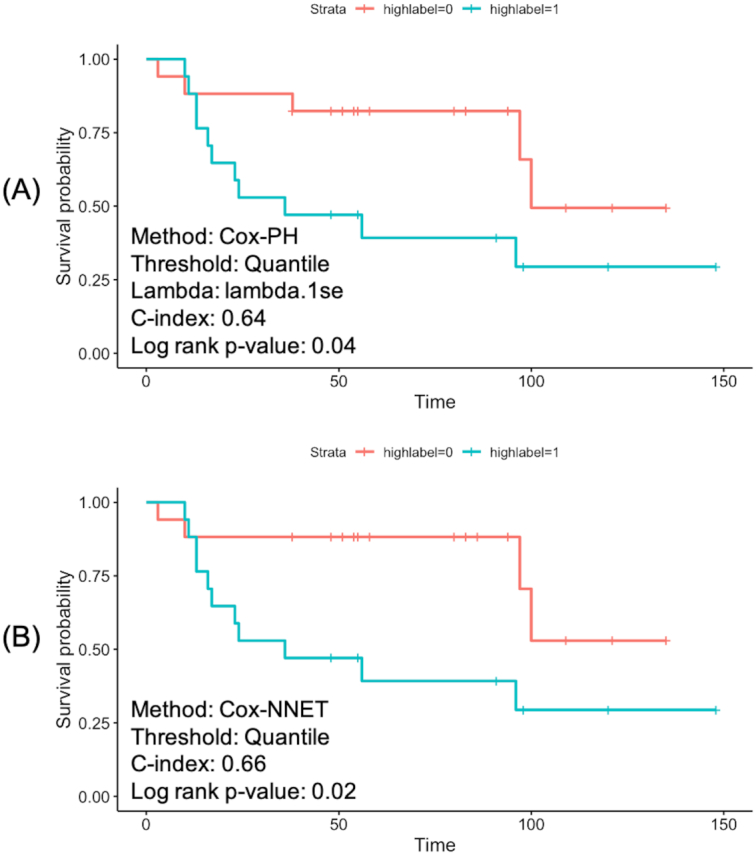
Comparison of Kaplan-Meier curves resulting from Cox-PH and Cox-nnet. The samples are dichotomized into 2 risk groups by the first quantile of the prognosis index (PI) score. (A) Cox-PH model. (B) Cox-nnet model with 3-layer neural network: 1 input layer, 1 fully connected hidden layer, and the output layer.